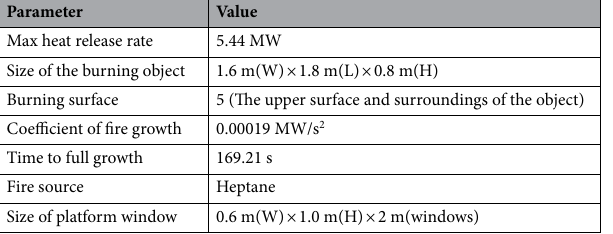
Table 4. Setting of parameters in numerical